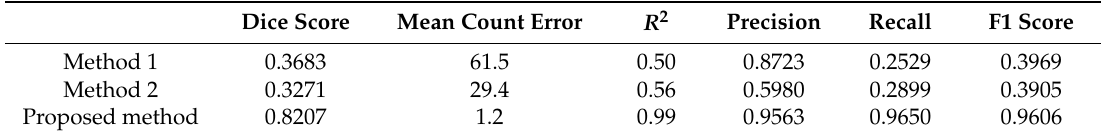
Table 1. Segmentation and counting performance of method 1, method 2 and the proposed method (CNN-4-4) on 34 test images.